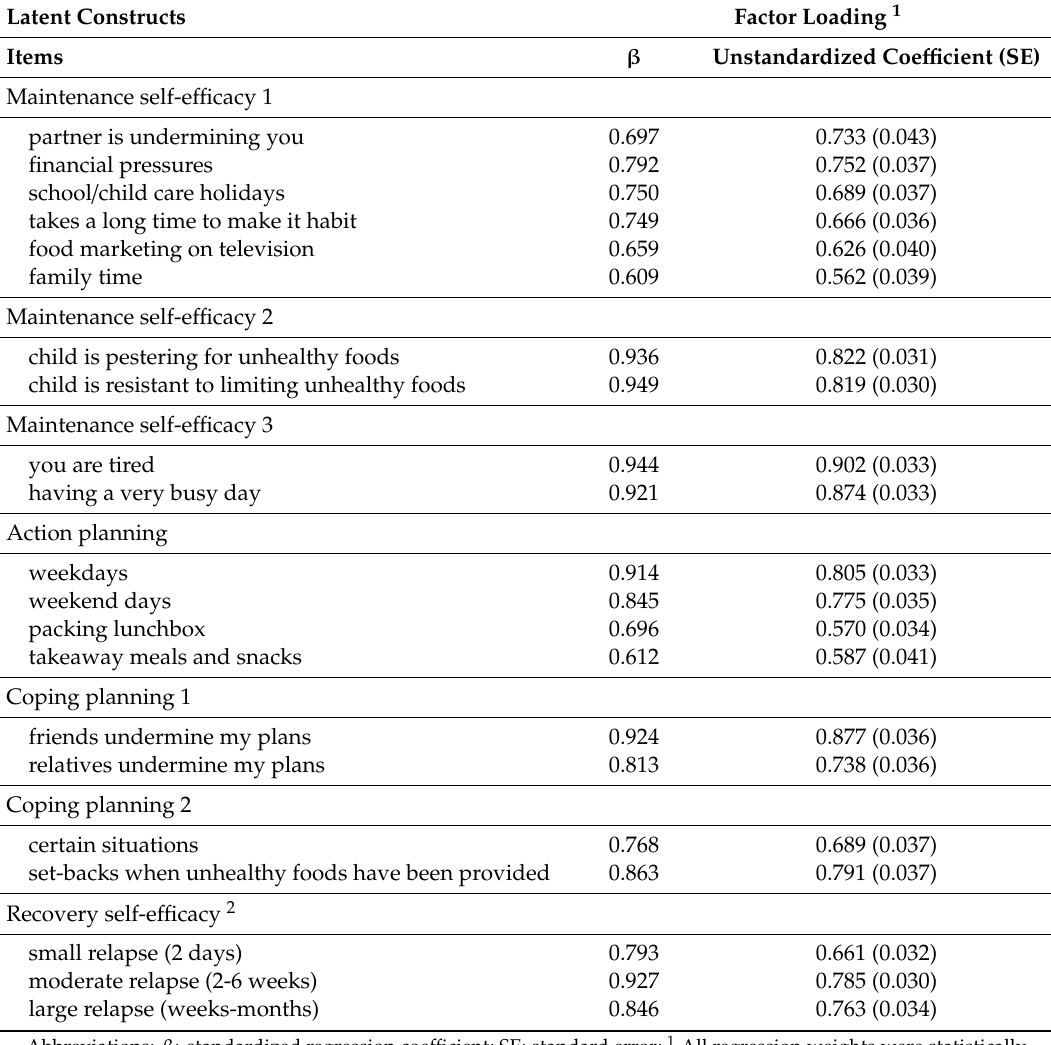
Table 3. Final one factor model confirmatory factor analysis regression weights for volitional phase latent